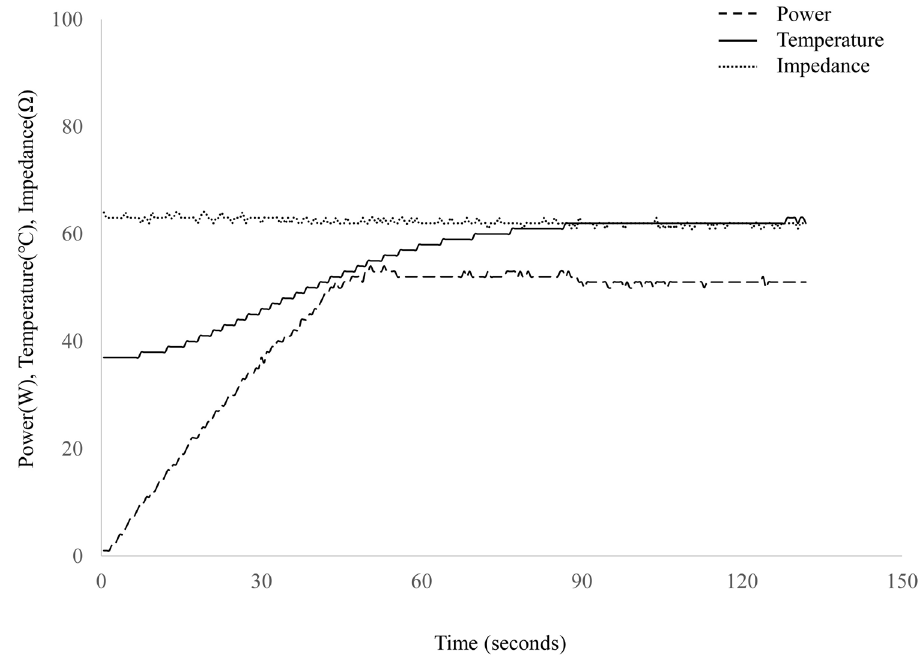
Figure 4. An example of the power, temperature, and impedance statuses during the ablation. The output power was increased linearly until the target temperature was reached and was adjusted continually to maintain the temperature.